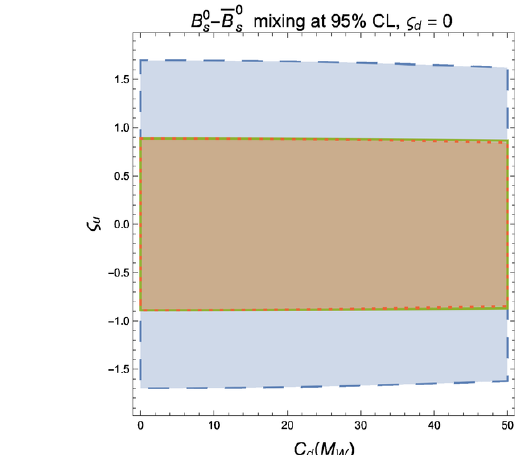
Figure 8. The left (right) panel shows the B 0 a (cid:12)xed value of & u = 0 ( & d = 0), in the CP-conserving limit and with di(cid:11)erent mass con(cid:12)gurations: A (red, dotted), B (green, solid line) and C/D (blue,